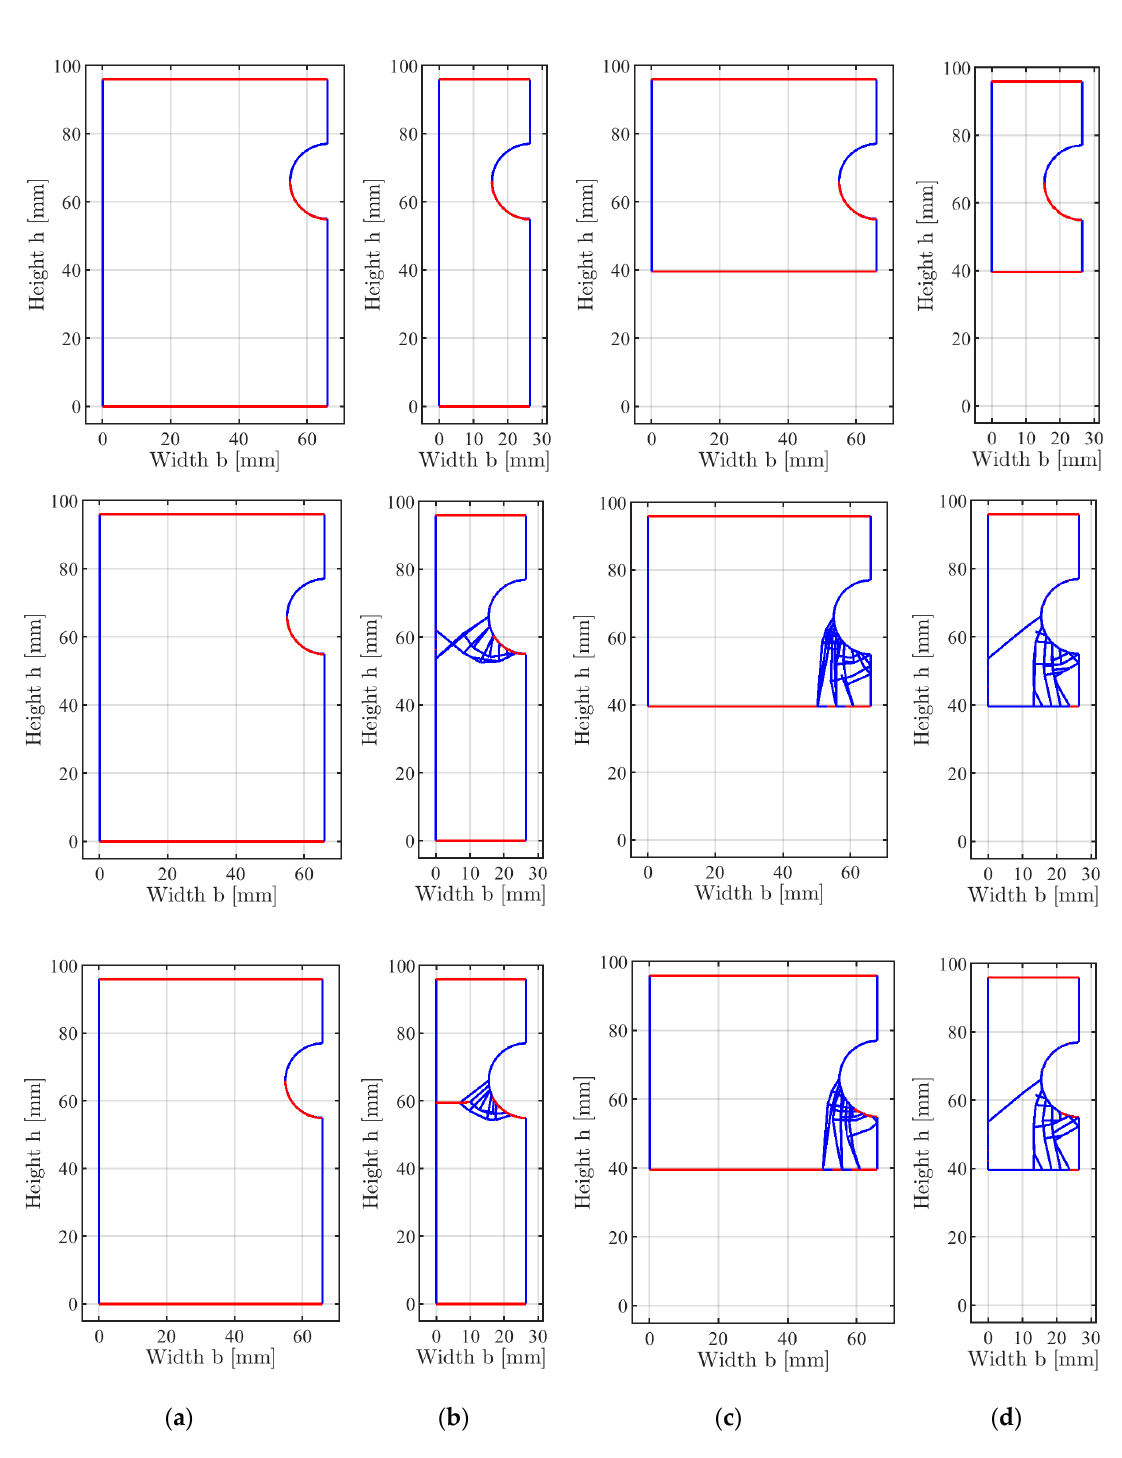
Figure 17. Failure mechanisms (blue: Slip displacements, red: Normal displacements) from DLO (top row: T resca and M ises criteria, k fy = 1.00; middle row: T resca criterion, k fy = 1.36; bottom row: M ises criterion, k fy = 1.36 ): ( a ) Case 1; ( b ) Case 2; ( c ) Case 3; ( d ) Case